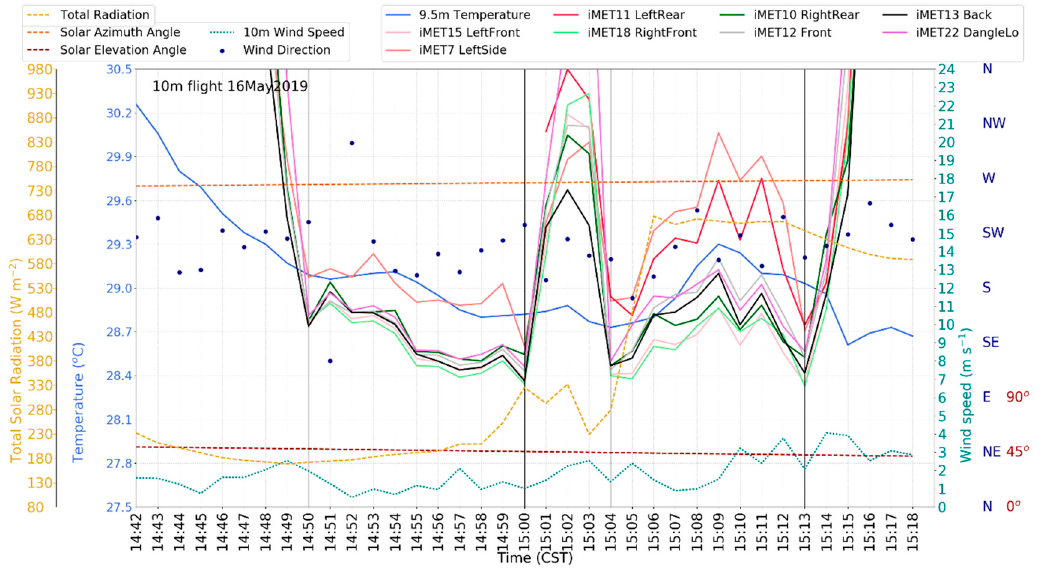
Figure 15. Time series from the 16 May 2019 of the tower temperature at 9.5 m (°C, solid blue), iMET-XQ temperatures (°C, various solid colors as shown in the legend), solar radiation (W m − 2 , dashed mustard yellow), solar azimuth angle (degrees, dashed orange) tower wind speed at 10 m (m s − 1 , dotted green), and the tower wind direction at 10 m (degrees, dark blue dots). The two vertical black lines indicate the start and end times of the 10 m flight.